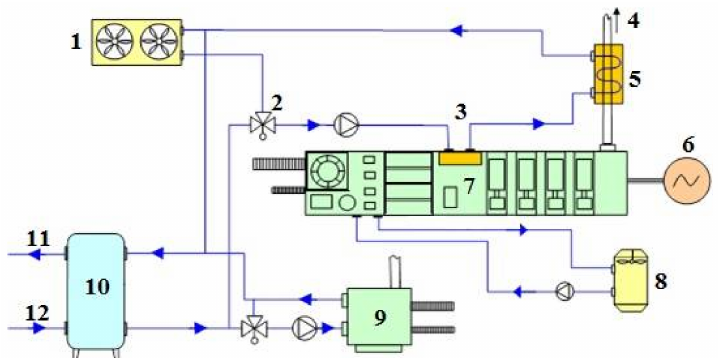
Figure 5. CHP system. 1 . Cooling (Air–Water) 200 kW; 2 . control valve; 3 . engine cooling; 4 . exhaust